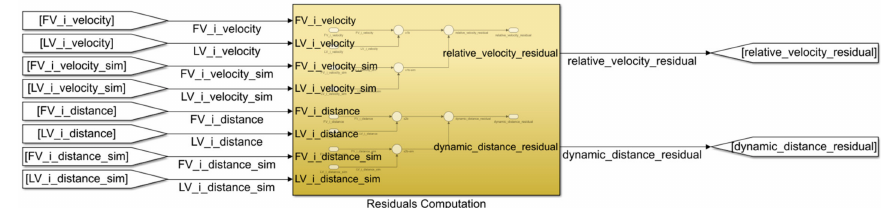
Figure 9. Residuals computation subsystem overview—implementation using Simulink (MATLAB